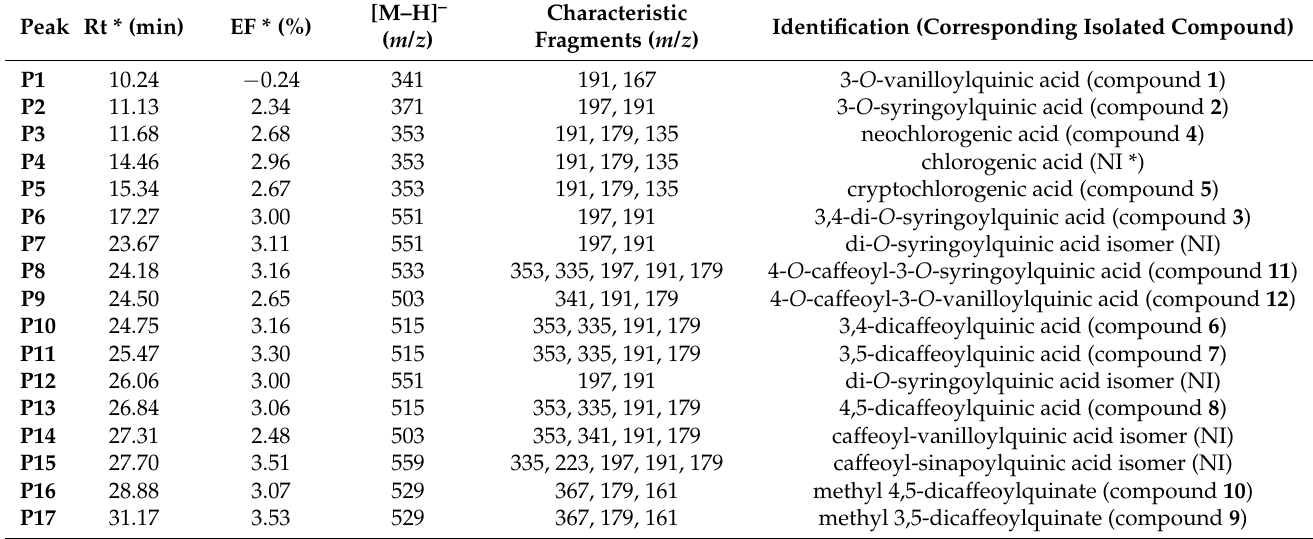
Figure 1. HPLC chromatograms of the Carissa spinarum ethyl acetate (EA) fraction without ultrafiltra- tion (black line, top), ultrafiltration with activated superoxide dismutase (SOD) (red line, middle), and ultrafiltration with inactivated SOD (blue line, bottom). Table 1. Identification of potential SOD ligands in the EA fraction of C. spinarum